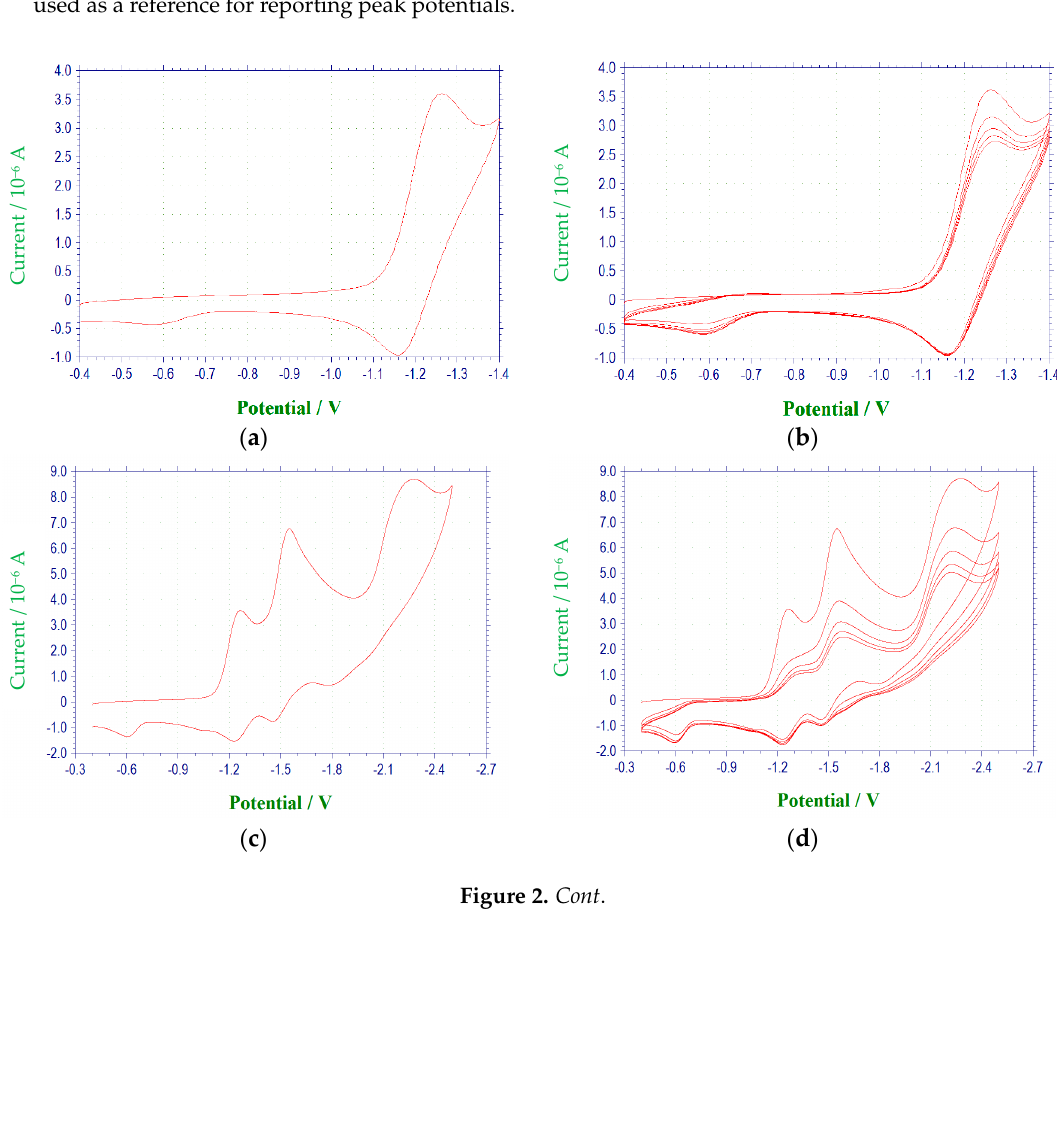
Figure 1. Cyclic voltammetric reduction of compound 1a in DMF at 100 mV/s (E vs. (Ag/AgNO 3 )/V): ( a ) single scan between − 0.4 and − 1.6 V; ( b ) multiple scans between − 0.4 and − 1.6 V; ( c ) single scan between − 0.4 to − 2.4 V; ( d ) multiple scans between − 0.4 and − 2.4 V; ( e ) single scan between − 0.4 and − 2.9 V; ( f ) first derivative cyclic voltammogram between − 0.4 and − 1.6 V; ( g ) first derivative cyclic voltammogram between − 0.4 and − 2.4 V; ( h ) Cyclic voltammogram for the ferrocene redox couple used as a reference for reporting peak potentials.